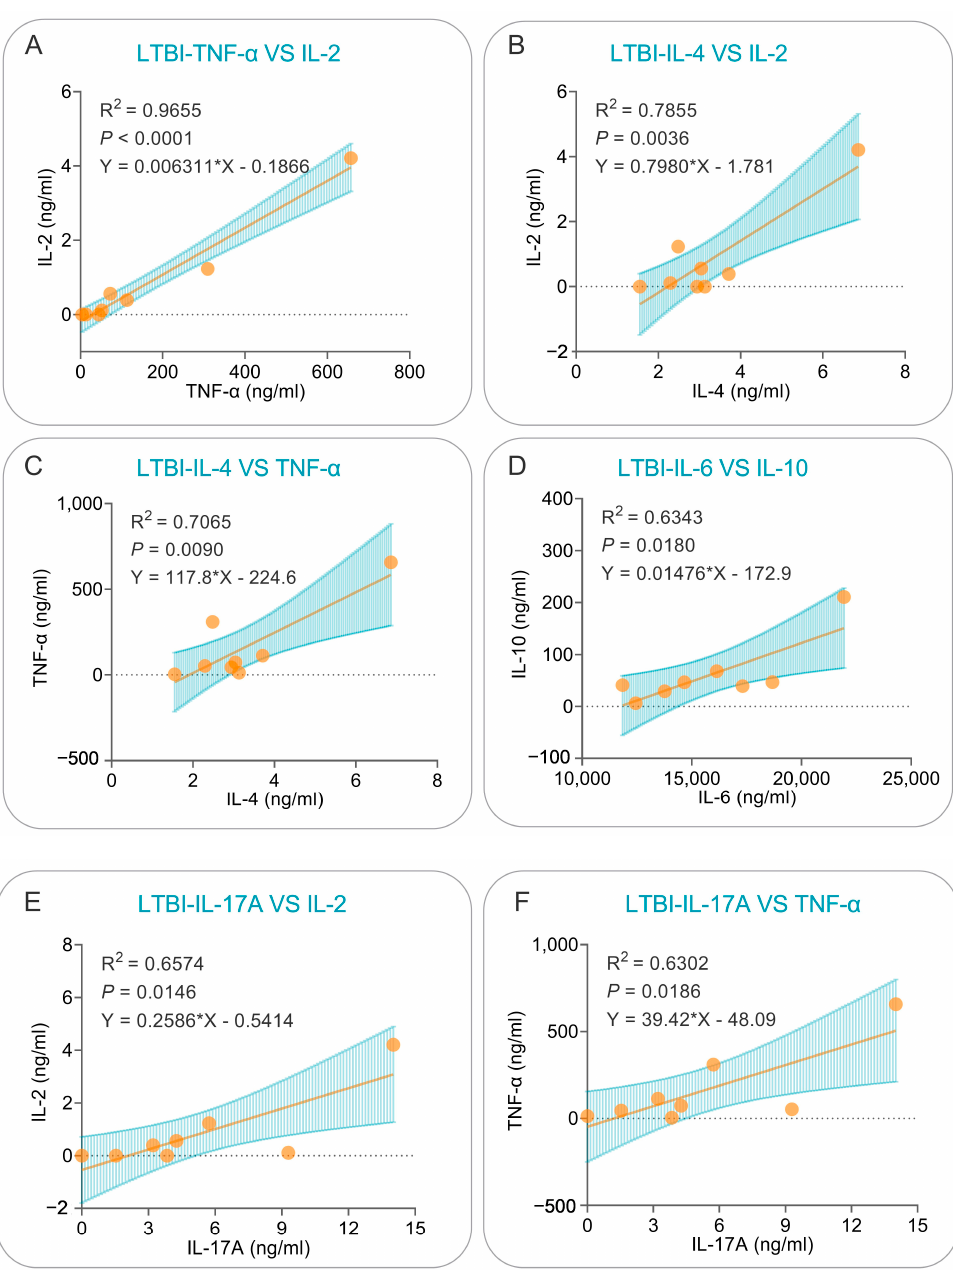
Figure 12C), IL-6 and IL-10 (R 2 = 0.6343, p = 0.0180, Y = 0.01476*X − 172.9, Figure 12D), IL-17A and IL-2 (R 2 = 0.6574, p = 0.0146, Y = 0.2586*X − 0.5414, Figure 12E), and IL-17A and TNF- α (R 2 = 0.6302, p = 0.0186, Y = 39.42*X − 48.09, Figure 12F) cytokines; (2) simi- larly, significant positive correlations were observed between PP19128R-induced IFN- γ and TNF- α (R 2 = 0.6708, p = 0.0242, Y = 107.7*X − 523.7, Figure 13A), IL-6 and TNF- α (R 2 = 0.7989, p = 0.0067, Y = 0.1831*X − 2862, Figure 13B), IL-6 and IFN- γ (R 2 = 0.6224, p = 0.0350, Y = 7.554*X − 7.930, Figure 13C), and IL-17A and IL-10 (R 2 = 0.7218, p = 0.0155, Y = 0.001323*X − 14.71, Figure 13D) cytokines.